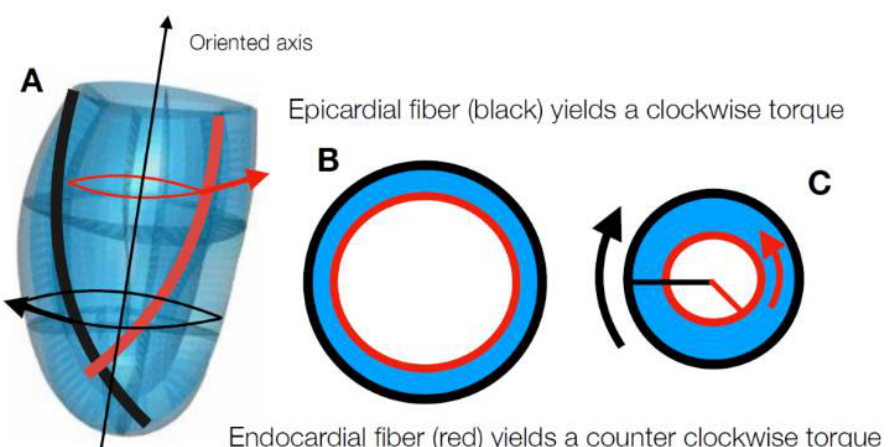
Figure 1. Cartoon showing the torque generation in LV muscular wall. ( A ) Epicardial fibers (black) have a left-handed helical pattern, while the endocardial ones (red) have a right-handed helical pattern. As a consequence, the hoop component of the contraction generates a torque around the vertical axis of the LV: epicardial fibers yield a clockwise torque, while the endocardial ones yield a counterclockwise torque. ( B ) Cross section of the LV at diastole, when contraction is null. ( C ) Cross section of the LV at systole, when contraction is high. If the contractile force is equal in the epicardial and endocardial fibers, the epicardial torque (black) is larger than the endocardial one (red), being different from the lever arm.